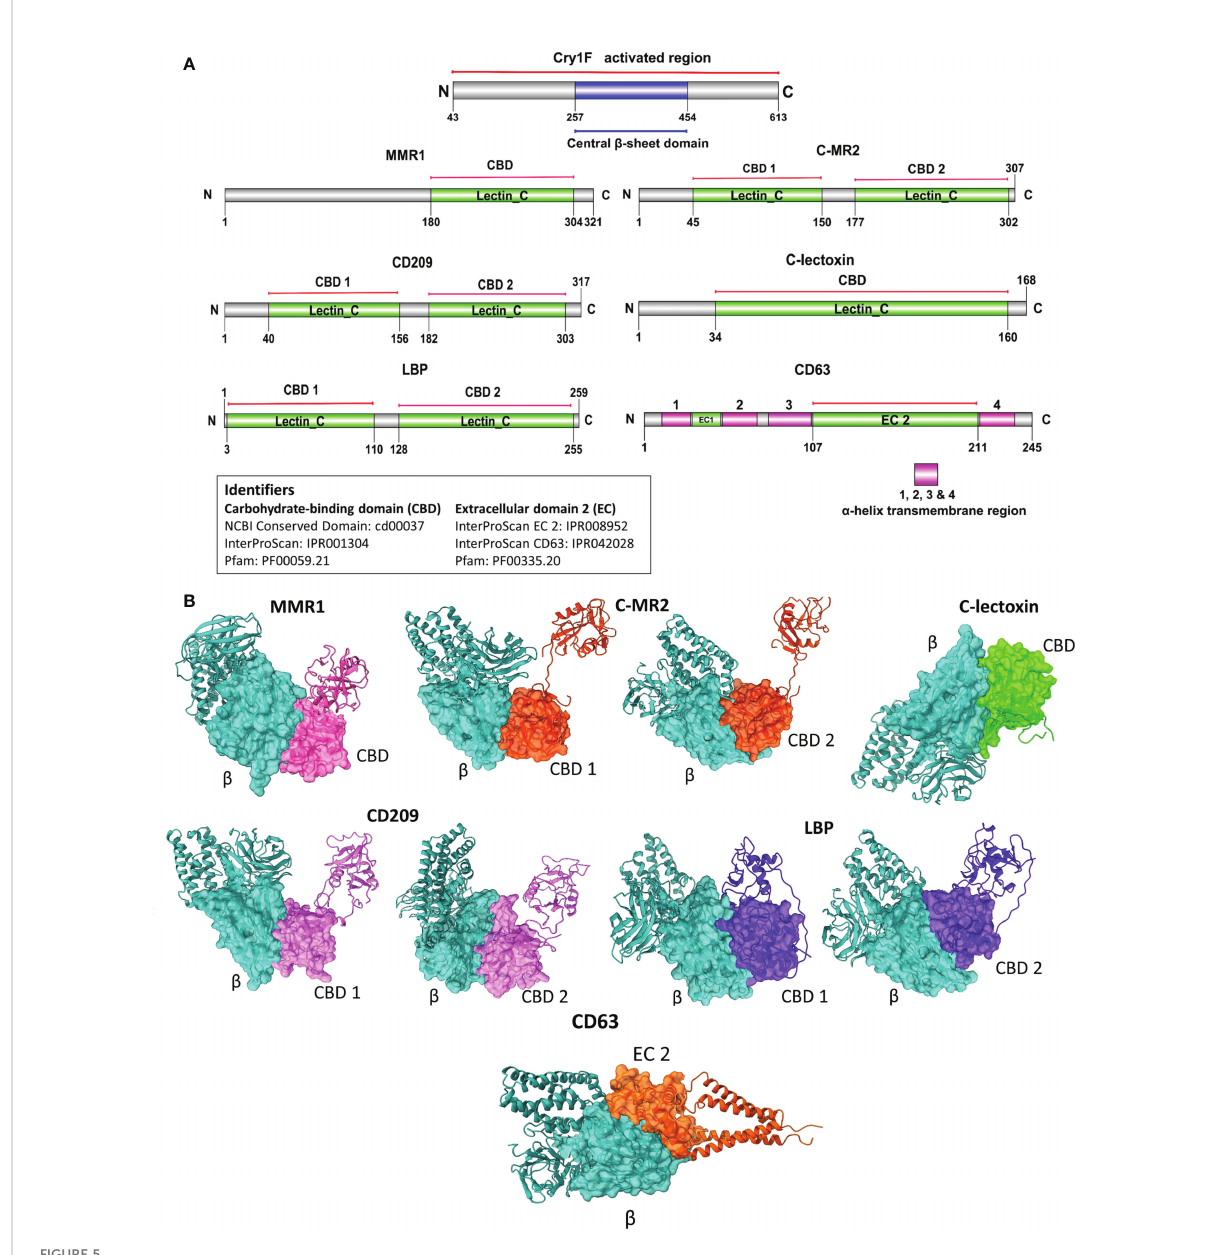
FIGURE 5 Domain-based protein-protein interaction (PPI) in silico analysis of C-type lectins and tetraspanin with domain II of Cry1F. (A) Protein domains identi fi ed in C-type lectins, tetraspanin and Cry1F by NCBI Conserved domain, Pfam or InterProScan. (B) The PPI complexes of Cry1F with C- type lectins and tetraspanin ( b = Central b -sheet domain II of Cry1F, CBD 1 & D2 = Carbohydrate-binding domains, EC 2 - ectodomain EC